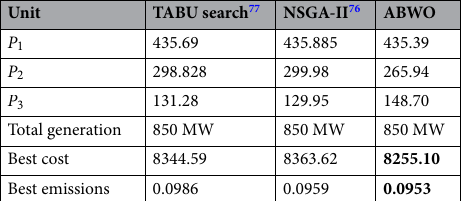
Table 13. ABWO comparison with other heuristic techniques for case study-V. Significant values are in bold.